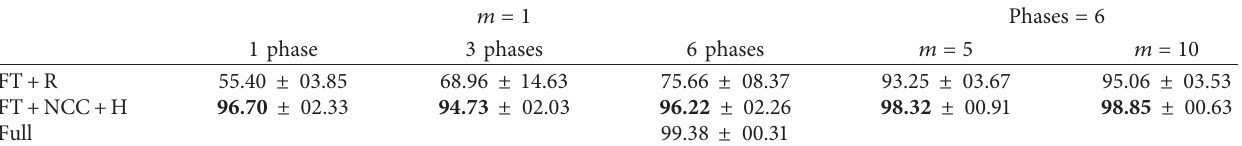
Table 5: Accuracies and standard deviations (SD) over AMCF using a different number of incremental phases and